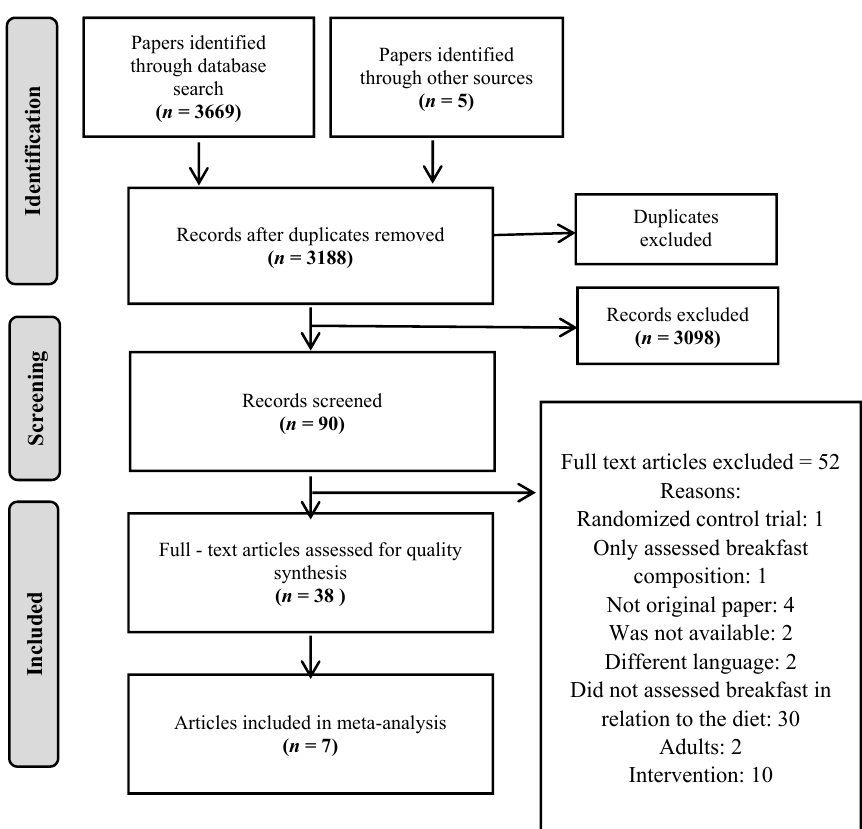
Figure 1. Flow diagram of the literature search process.